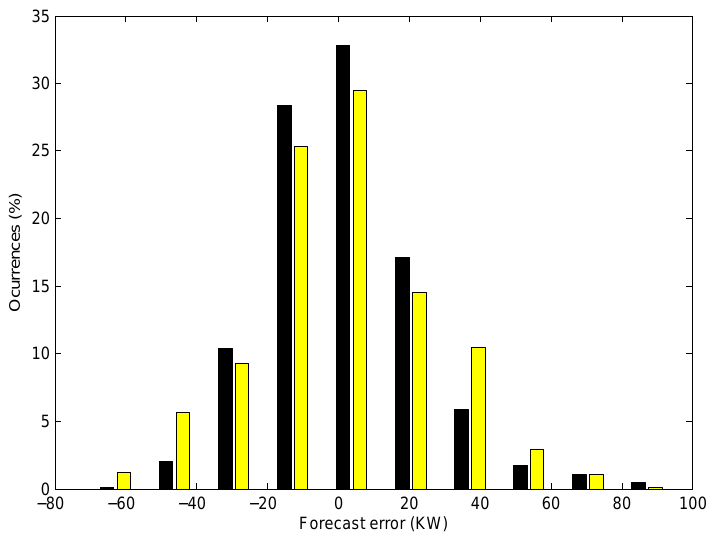
Figure 3. Histogram of errors obtained for data-set E2 using the proposed model with (black bars) and without adaptation (yellow